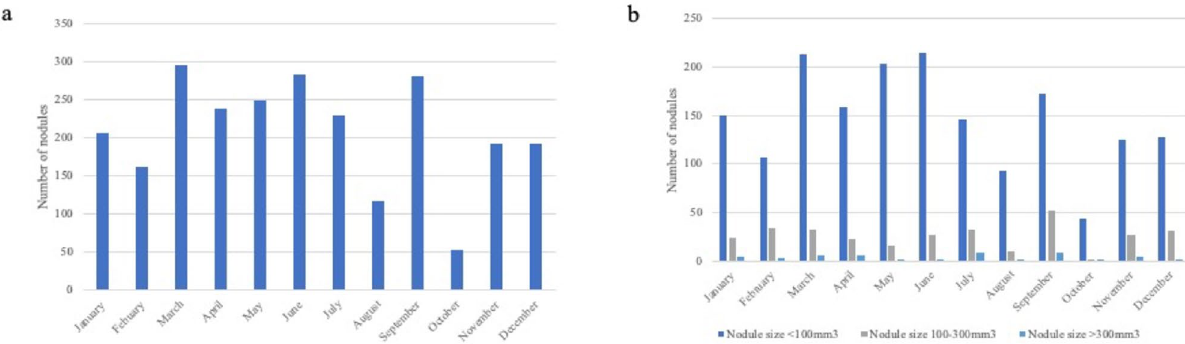
Figure 3. Monthly distribution of total nodules and non-calcified solid lung nodules detected in ImaLife participants based on nodule size categories. ( a ) Overview of the total number of lung nodules detected per month. ( b ) Overview of the number of lung nodules detected per nodule size category per month: nodule size < 100 mm 3 (< ~ 6 mm), nodule size 100–300 mm 3 (~ 6–8 mm) and nodule size > 300 mm 3 (> ~ 8 mm).